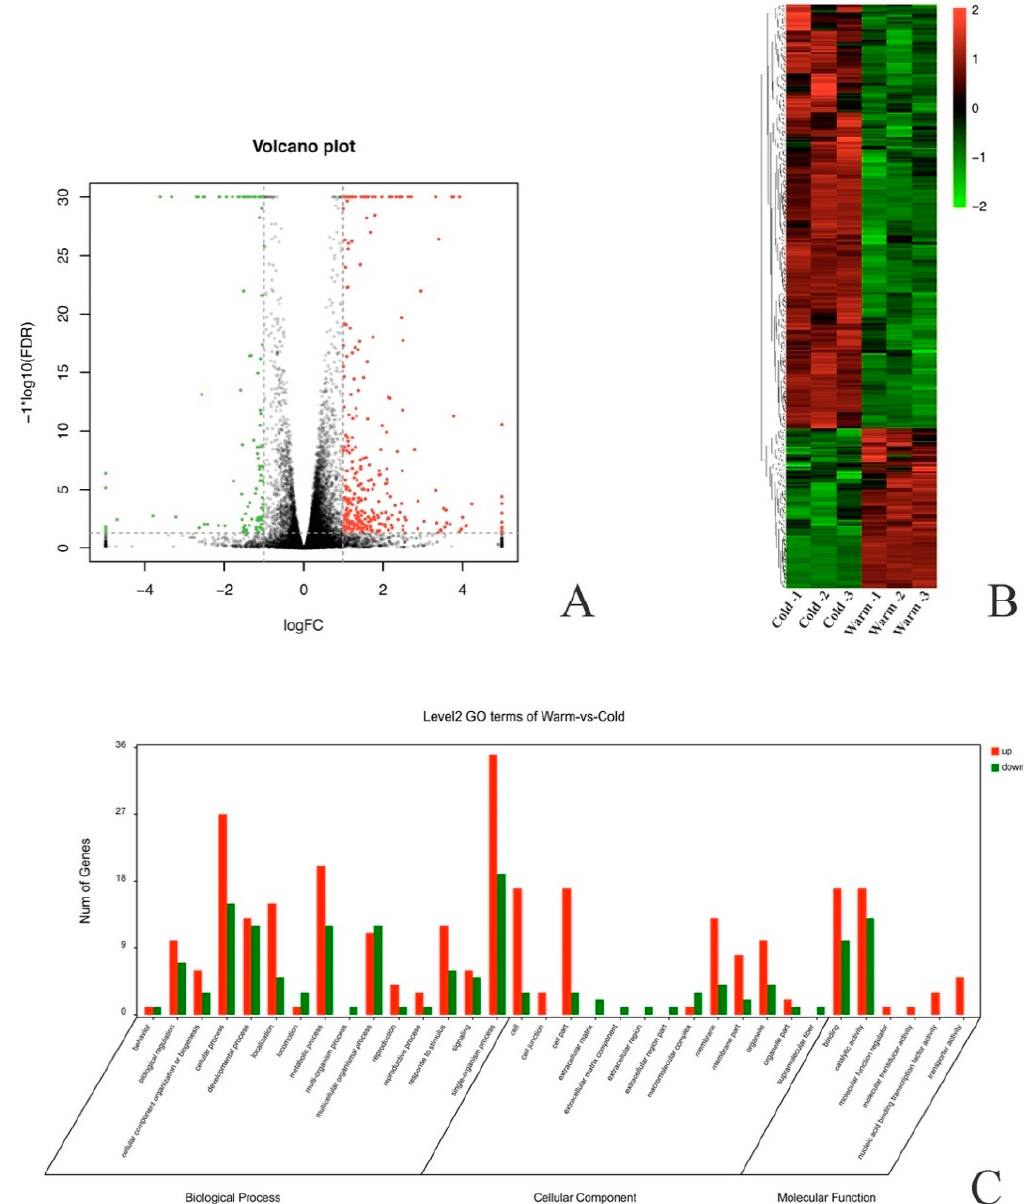
Figure 2. Di ff erentially expressed genes (DEGs) analysis. ( A ). DEGs between low-temperature-treated Figure 2. Differentially expressed genes (DEGs) analysis. (A). DEGs between and CK group nematodes. Red dots represent up-regulated genes and green dots represent low-temperature-treated and CK group nematodes. Red dots represent up-regulated genes and down-regulated genes. ( B ). Heat map of all the DEGs between low-temperature-treated and CK green dots represent down-regulated genes. (B). Heat map of all the DEGs between group nematodes. ( C ). Gene Ontology (GO) categories of DEGs between low-temperature-treated and low-temperature-treated and CK group nematodes. (C). Gene Ontology (GO) categories of DEGs CK group between low-temperature-treated and CK group nematodes.